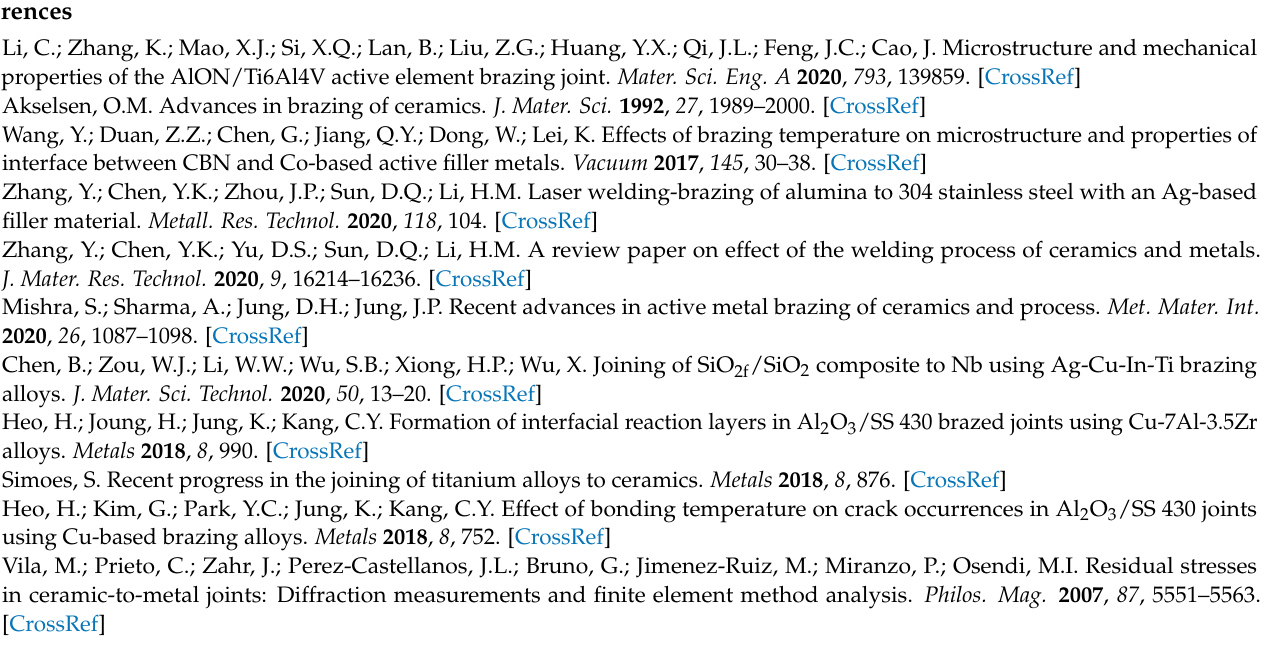
brazed sample for the pressure drop test, Figure S4: The apparatus of pressure drop